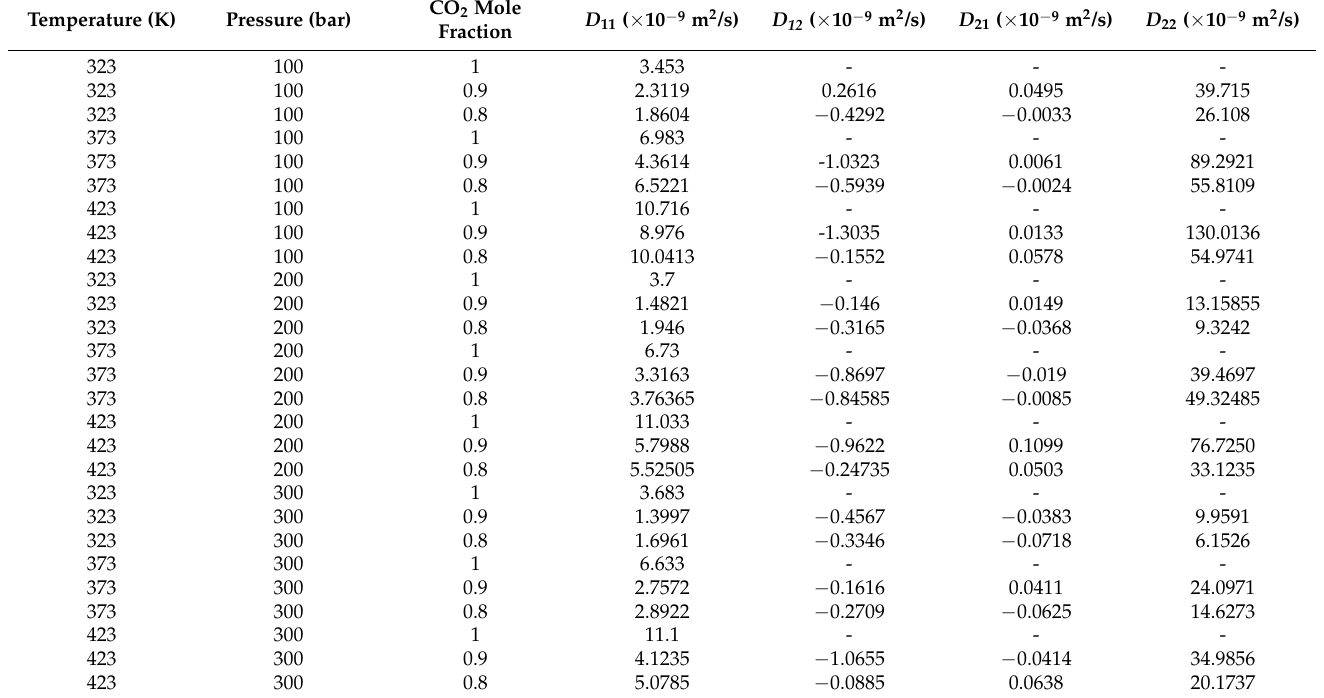
Table 2. Fick diffusion coefficients of CO 2 –N 2 –water system